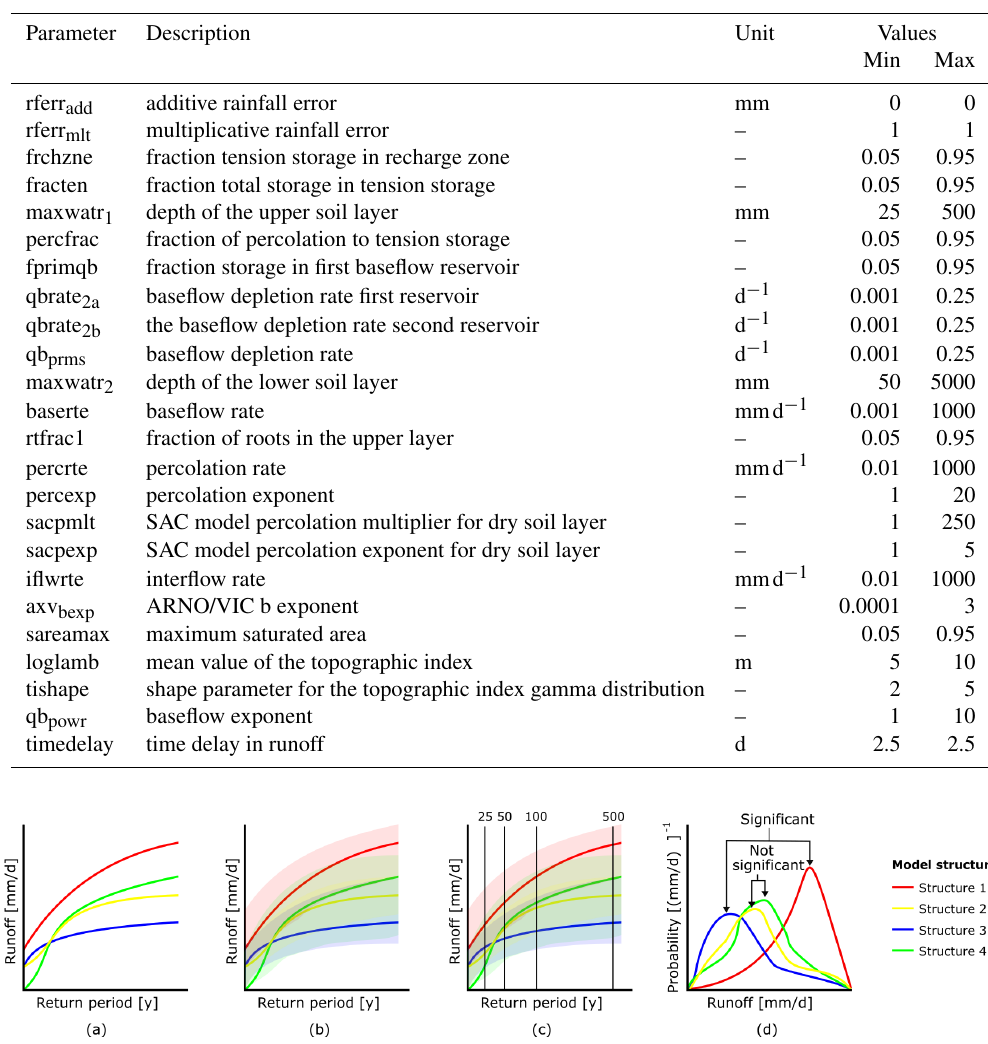
Figure 3. Illustration of the conducted procedure for the comparison of the extreme event magnitude. The four lines with different colours represent the different model structures (theoretical structure 1–4). (a) The simulated runoff can be plotted against return period for the different models. (b) The uncertainty bounds are due to the 100 different parameter samples per model. (c) The parameter samples were compared at different return periods. (d) The projected difference between the distributions at a given return period of the various model structures was tested using a two-sample t test; an example of a significant and a not-significant difference is